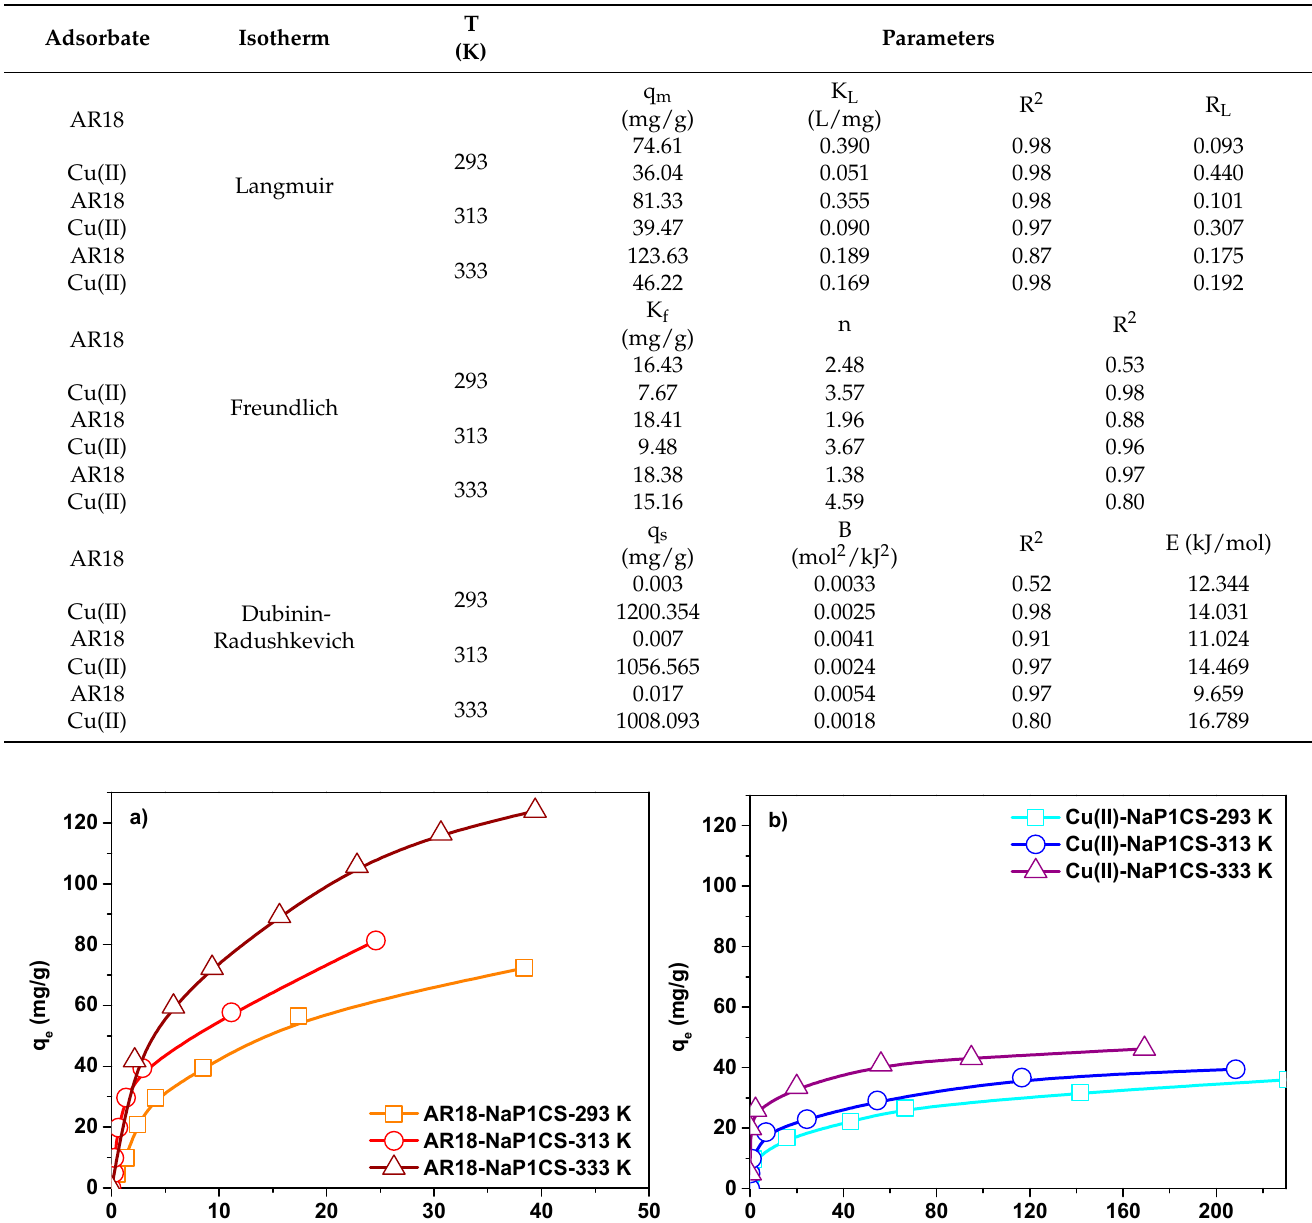
Table 4. Isotherm parameters for AR18 and Cu(II) adsorption on NaP1CS.